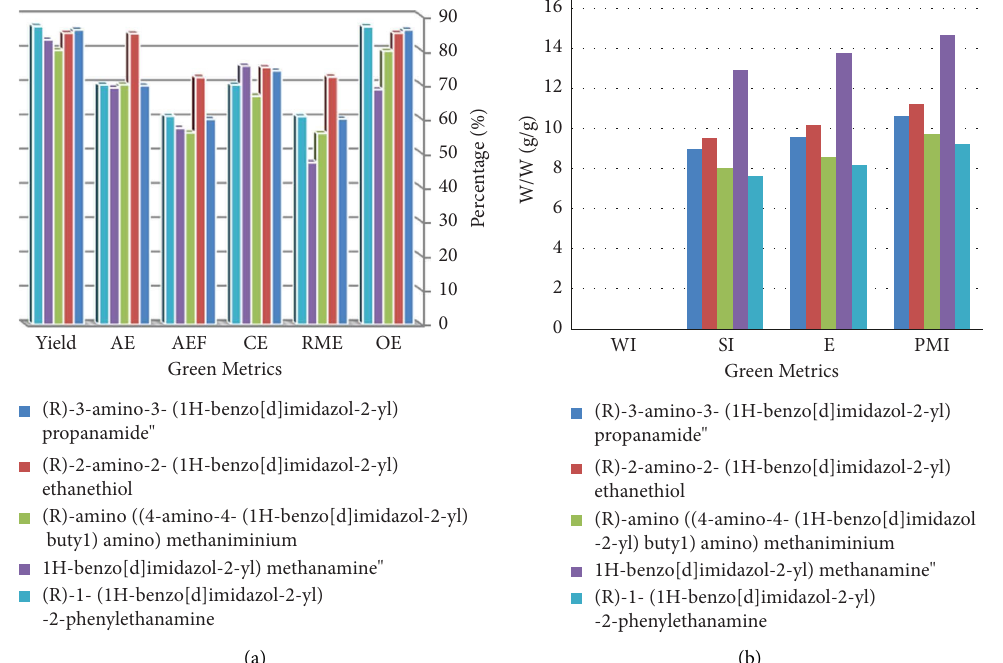
Figure 13: Green metrics including (a) AE, AEf, CE, RME, and OE. (b) PMI, E, SI, and WI for synthesis of the chiral benzimidazole derivatives with trinuclear cationic copper (II) complex as the